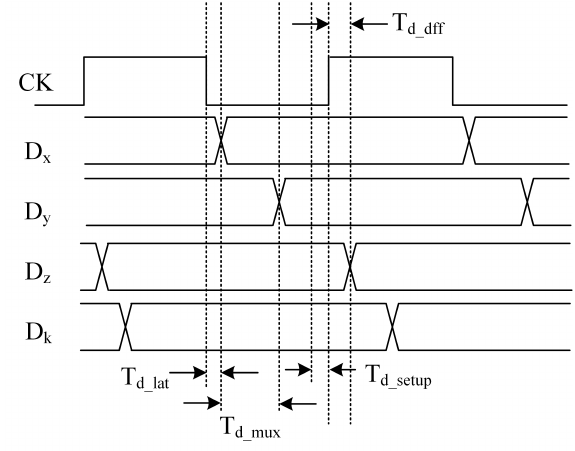
Figure 7. Proposed precoding sequence diagram.